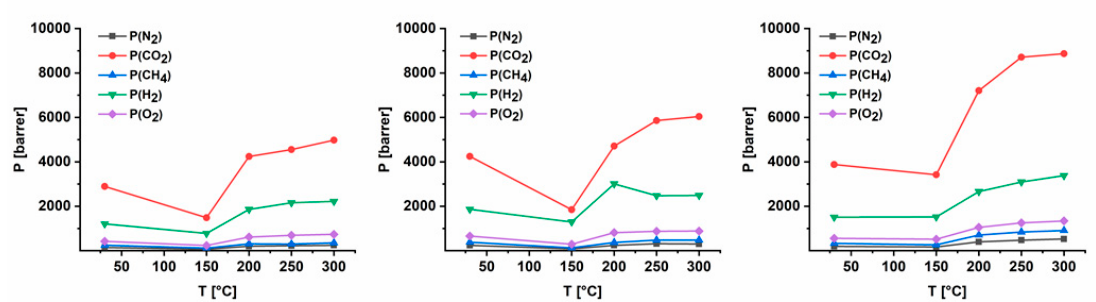
Figure 6. Permeability coefficients of AZ-PIM-100 (left), AZ-PIM-R50 (middle) and AZ-PIM-A50 (right) measured approximately 20 h after temperature treatments.